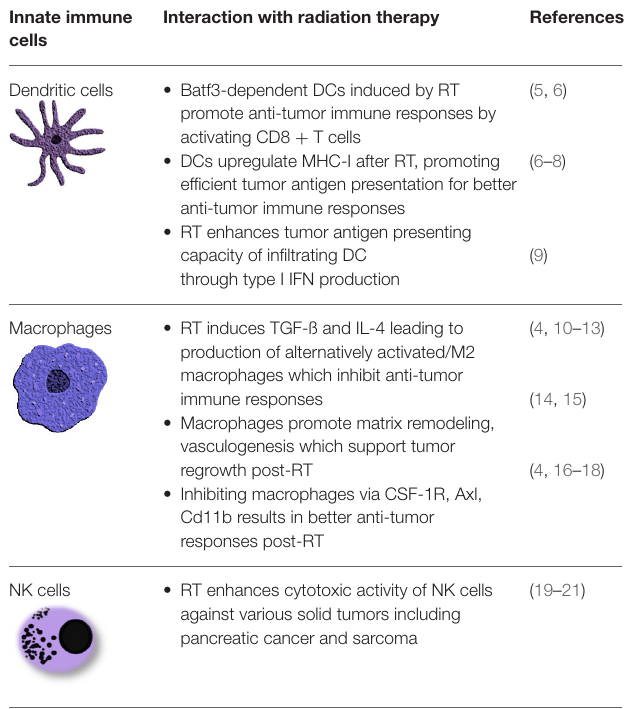
TABLE 1 | Summary of immune cells in the tumor microenvironment. Innate immune Interaction with radiation cells